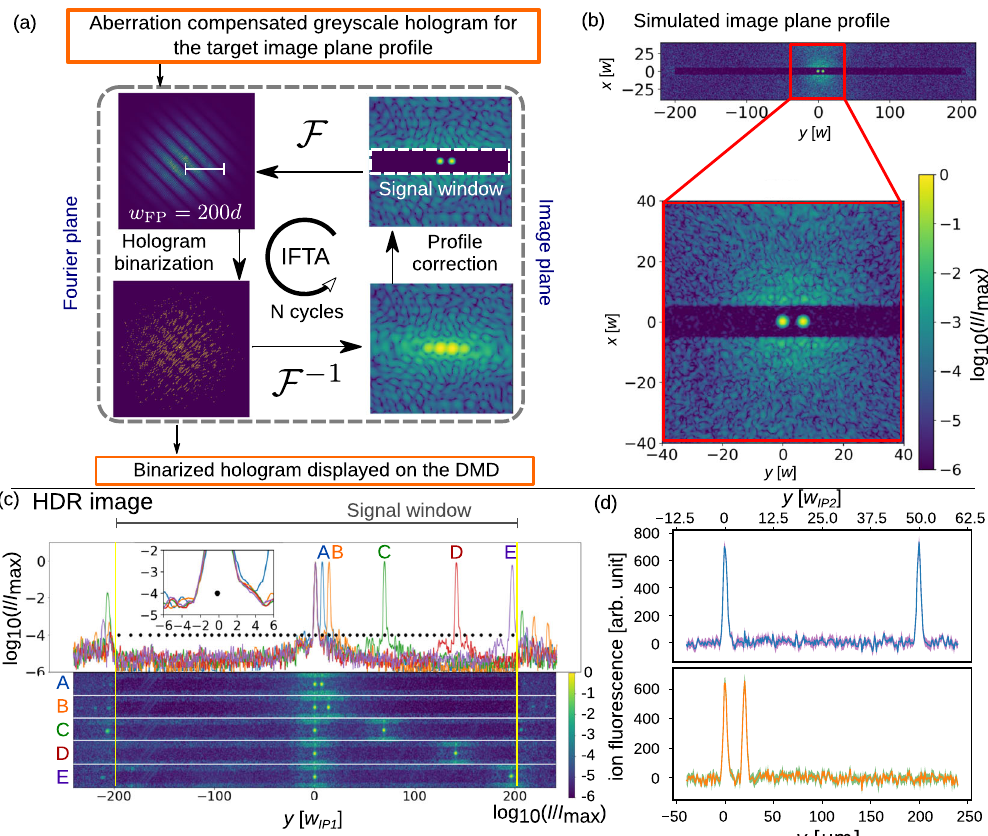
Fig. 4 DMD hologram generation for high-precision optical addressing. a Illustration of the iterative Fourier transformation algorithm (IFTA) for programming holograms to create two Gaussian spots. We fi rst binarize the ideal, aberration-corrected, and gray-scale hologram (from Eq. (1), which has a Gaussian envelope of width w FP = 200 d ) by setting a dynamic threshold (Supplementary Information) on each mirror. The Fourier transformed pro fi le in the image plane differs from the target pro fi le due to this binarization. We numerically fi x this error within a user-de fi ned signal window at the image plane, by substituting the fi eld pro fi le with the target pro fi le. The inverse Fourier transform of this modi fi ed pro fi le results in another gray-scale hologram which will be binarized again in the next iteration. We iterate this procedure to achieve the numerical accuracy of the electric fi eld within a small error of the target pro fi le ( N = 2000 iterations here). b Numerical simulation of two Gaussian addressing beams at the image plane with a binary hologram created by IFTA. c Intensity pro fi le of Gaussian spots ( w IP1 = 10 μ m) measured by the camera C1 at IP1 suitable for addressing various pairs (A through E) in a chain of 53 174 Yb + ions. Expected equilibrium positions of ions are represented by black dots and superimposed on the image (with ×30 magni fi cation, see Supplementary Information). The top panel shows a cross-section of the signal window (a close-up shown in the inset) from the high dynamic range (HDR) images shown in the bottom panel. Each HDR image is composed of fi ve images with exposure times varying in steps of 10× from 120 μ s to 1.2 s. d Fluorescence signal (see “ Methods ” section) of an 174 Yb + ion when illuminated by an addressing beam pro fi le consisting of two Gaussian spots of waist w IP2 = 4 μ m each. The beam is scanned on the ion identically as in Fig. 3f, and the shaded region indicates the standard